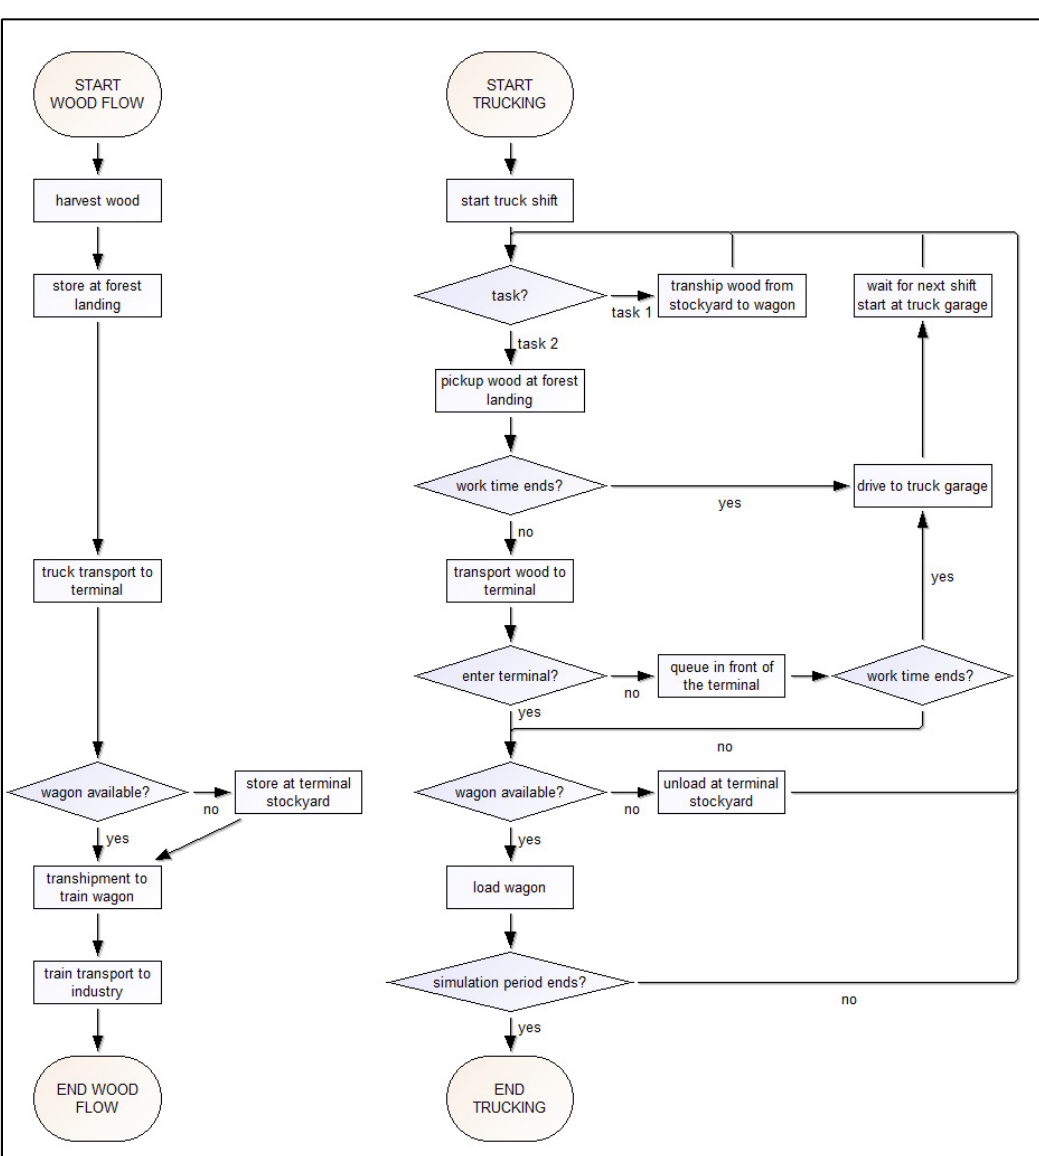
Figure 1. Flowcharts of the wood and transporting flows of the simulation model.